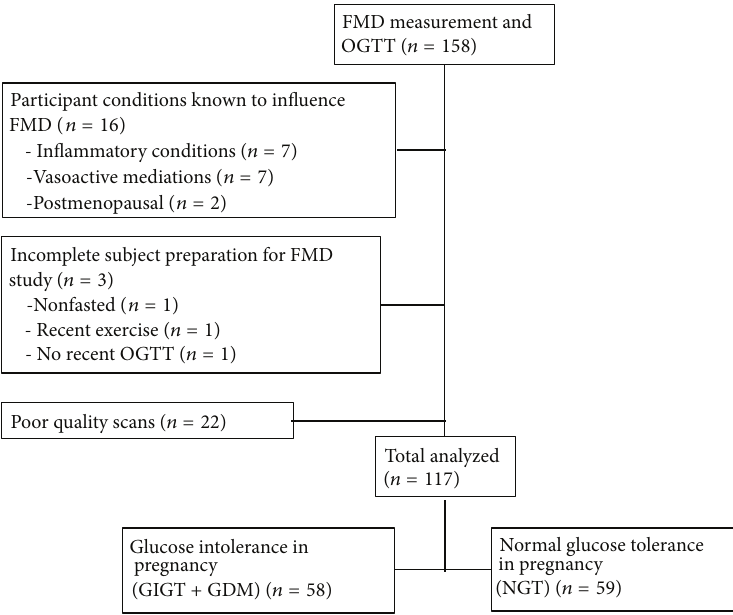
Figure 3: Schematic showing disposition of the study